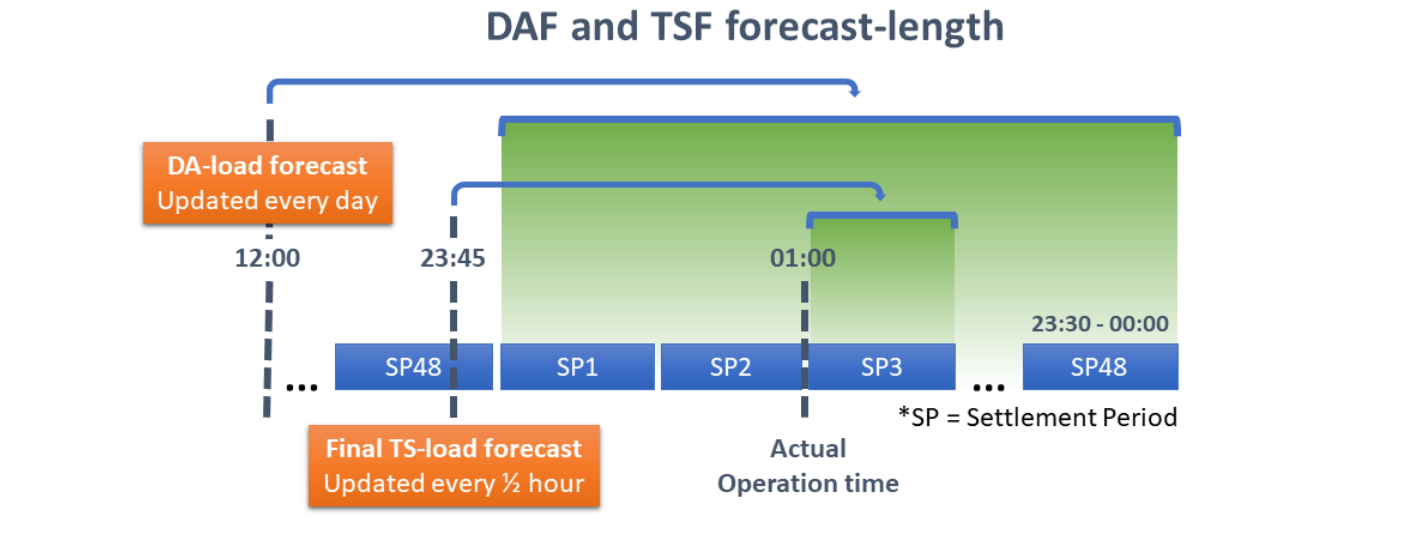
Figure 10. Illustration of the forecast lengths for the total day-ahead load forecast (DAF) and the final transmission system load forecast